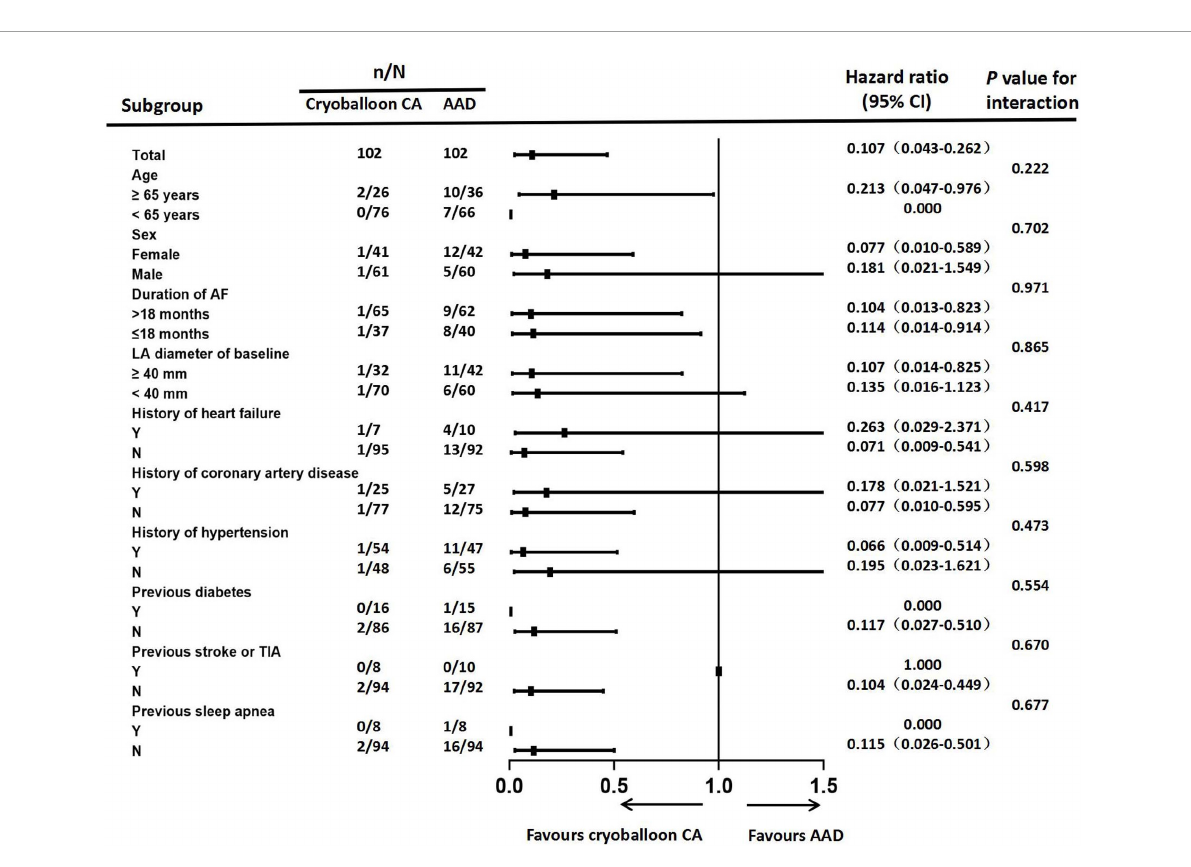
FIGURE4 Forest plot of progression from paroxysmal atrial fibrillation to persistent atrial tachyarrhythmia. Subgroup analyses of atrial fibrillation progression were performed according to patients’ baseline conditions. CA, catheter ablation; AAD, anti-arrhythmic drug; AF, atrial fibrillation; LA, left atrial; TIA, transient ischemic